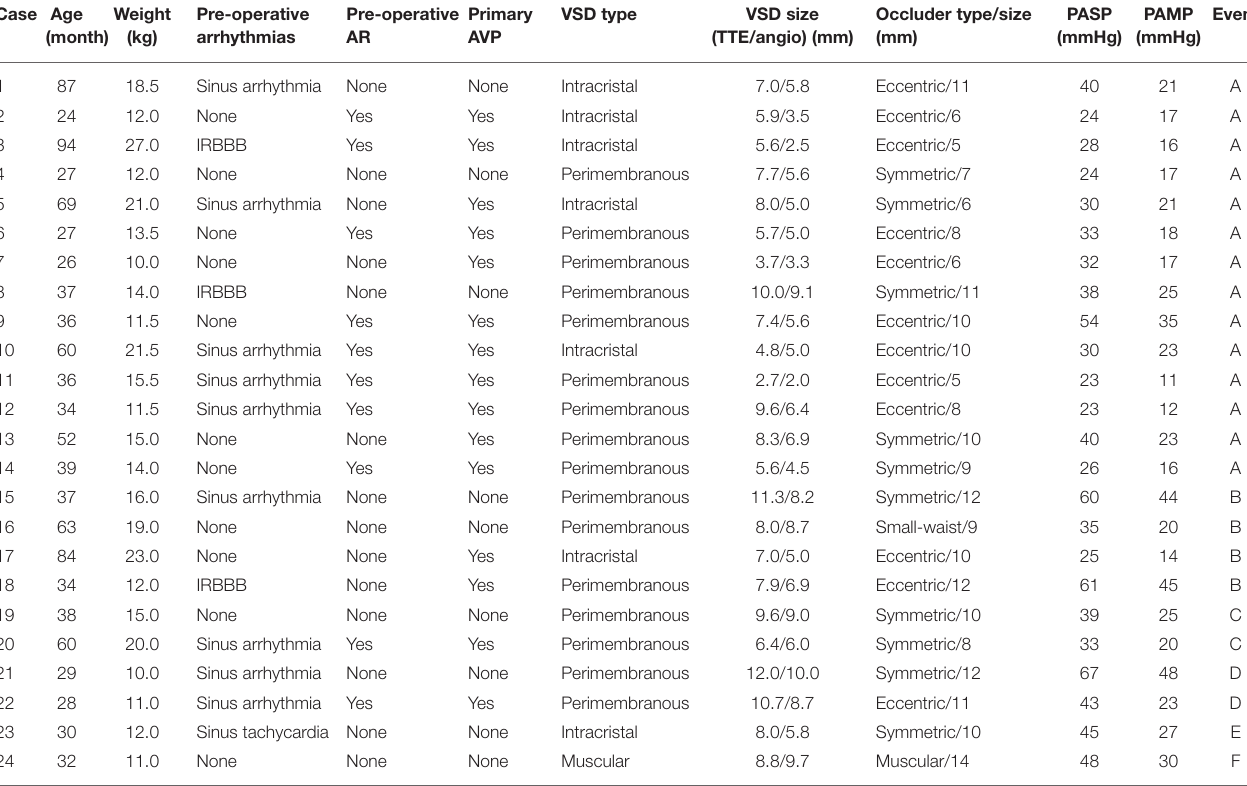
TABLE 2 | Demographics and clinical data of VSD patients who underwent unplanned surgery. Case Age Weight (month)